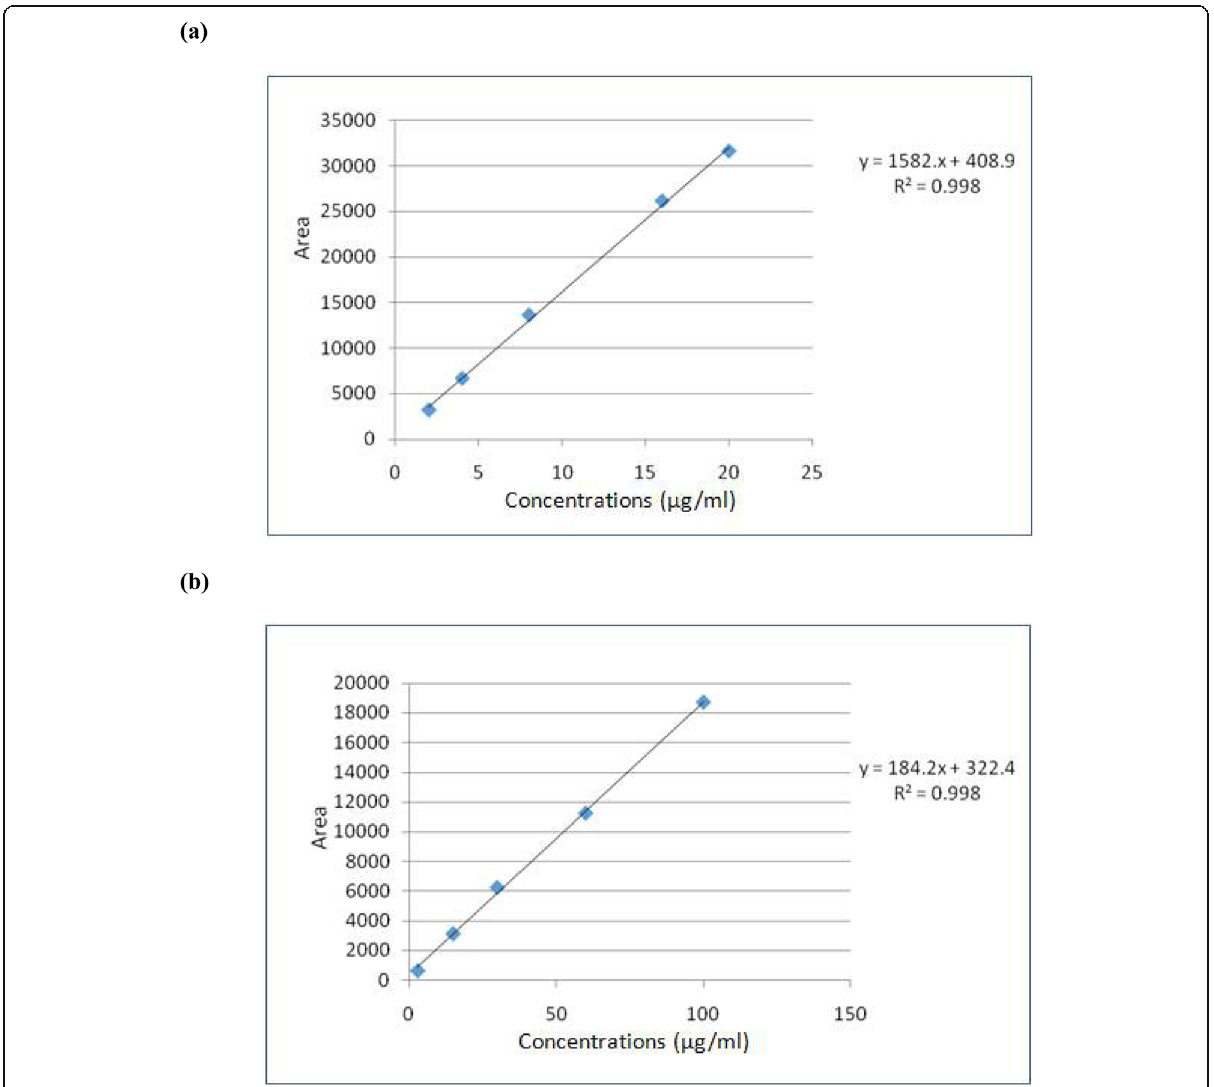
Fig. 4 a Calibration curve of valsartan. b Calibration curve of